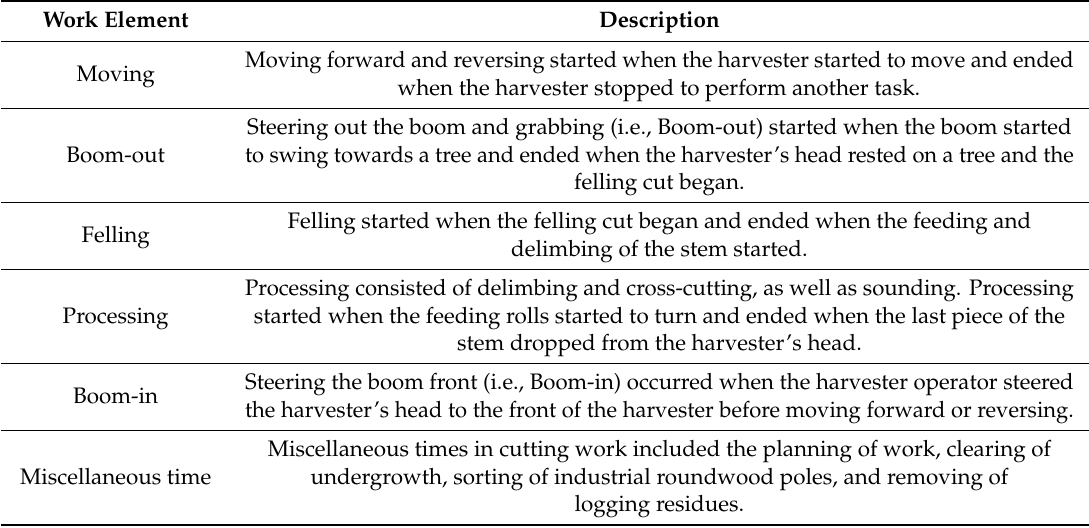
Table 2. Work elements of the stem cutting used in the time and motion